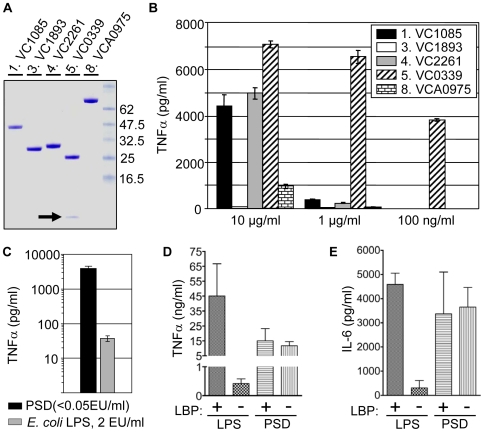
Further verification of screening results using purified recombinant proteins.(A) Purity of the purified proteins in SDS-PAGE. Molecular weight markers (in kDa) are shown on the right lane. One µg of each protein was separated in 4–12% SDS-PAGE. (B) TNFα production of RAW264.7 cells in response to each of five purified proteins. Three different protein concentrations were used to treat cells. Prior to being added to cells, LPS was removed from the protein solution to the level of <0.05 EU/ml. RAW264.7 cells were grown in DMEM plus 10% FCS for overnight and cells were treated with each protein in serum-free DMEM for 6 hrs. (C) TNFα production of RAW264.7 cells in response to the purified PSD (VC0339, 100 ng/ml)) and E. coli LPS in 2 EU/ml final concentration. The same E. coli LPS was used to make a standard curve for LPS quantification in the PSD sample. (D) Effect of the presence of LBP on TNFα production. RAW264.7 cells were treated with LPS (10 ng/ml) or PSD (100 ng/ml) in serum-free DMEM in the presence or absence LBP (100 ng/ml) for 6 hours. (E) Effect of the presence of LBP on IL-6 production. RAW264.7 cells were treated with LPS (100 ng/ml) or PSD (1 µg/ml) in serum-free DMEM in the presence or absence of LBP (100 ng/ml) for 6 hours.